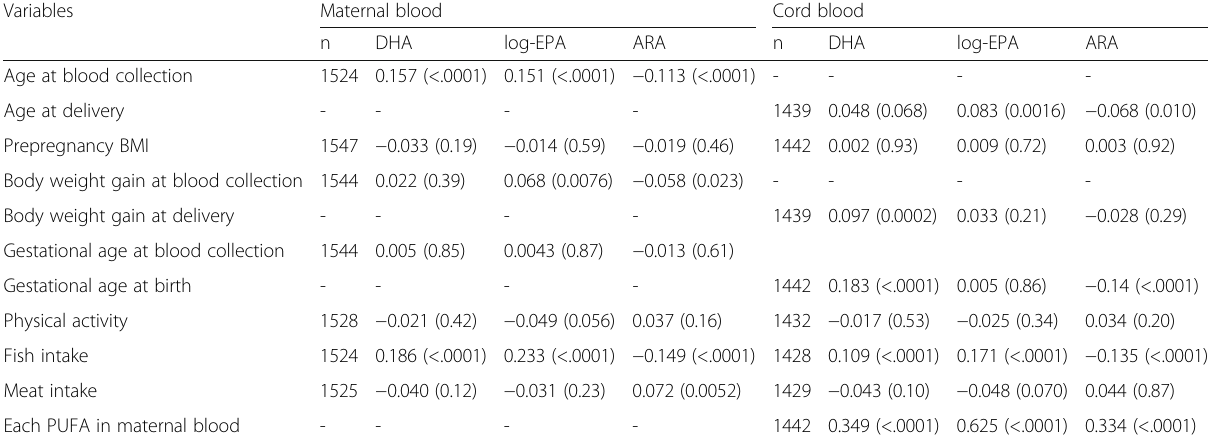
Table 3 Univariate associations between basic characteristics and PUFA levels in maternal and cord blood erythrocyte (Continuous